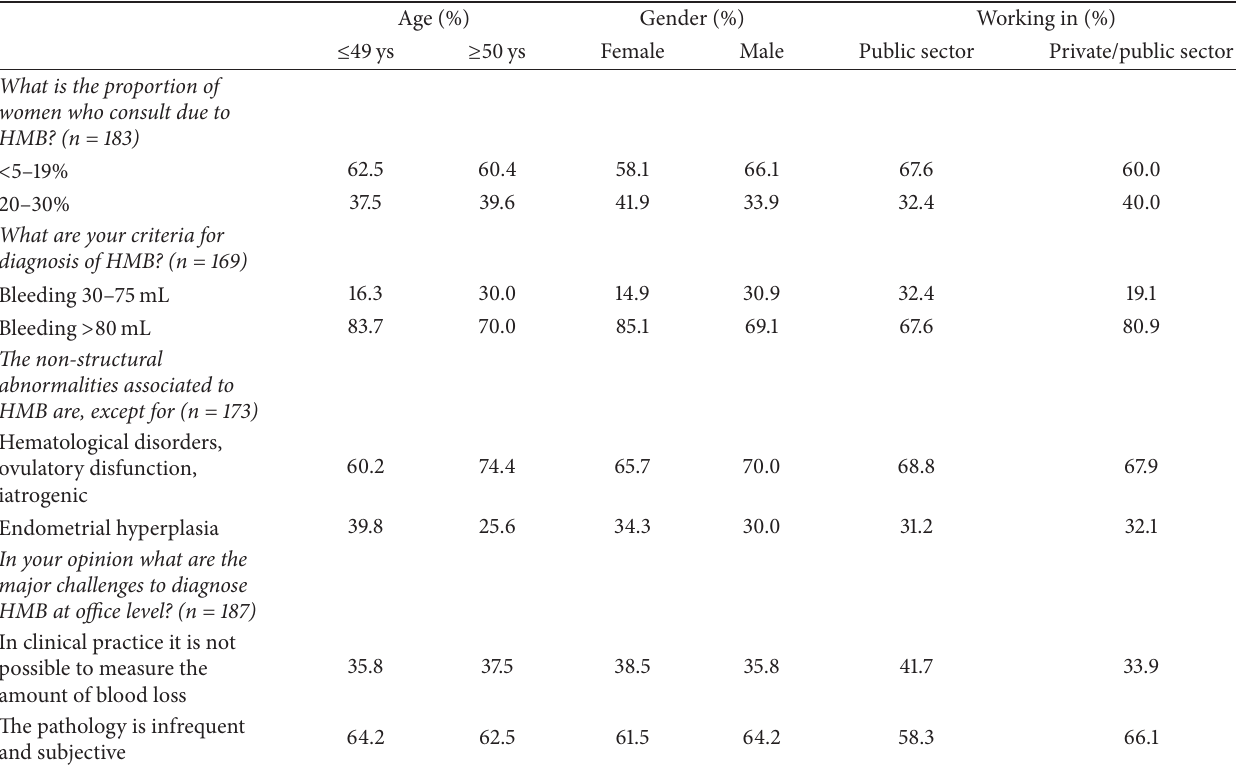
Table 1: Answers provided by the OBGYNs regarding some aspects of heavy menstrual bleeding (HMB).